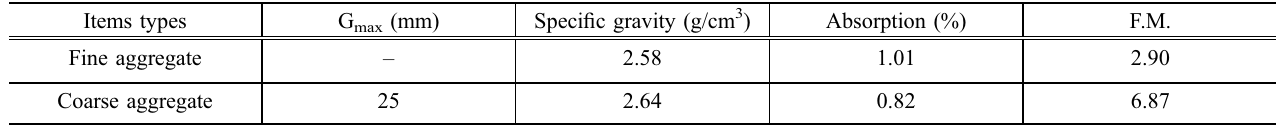
Table 3 Physical properties of the aggregates used.